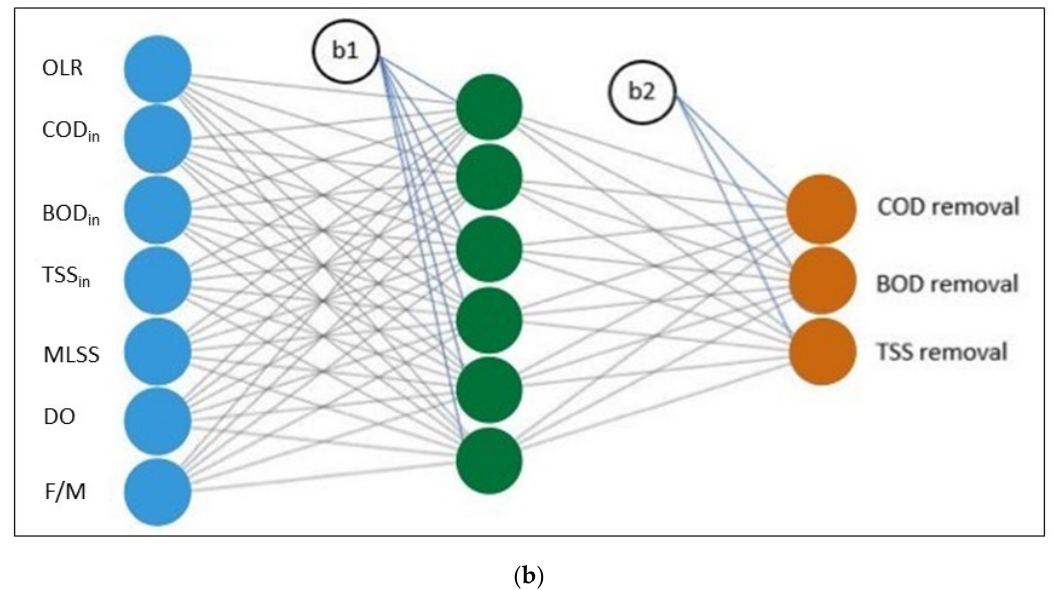
Figure 2. Neural network architecture for ( a ) anaerobic digestion, ( b ) aerobic process.